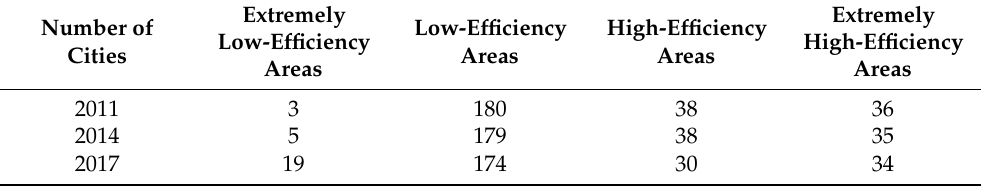
Table 2. Spatial and temporal distribution of ULGUE in